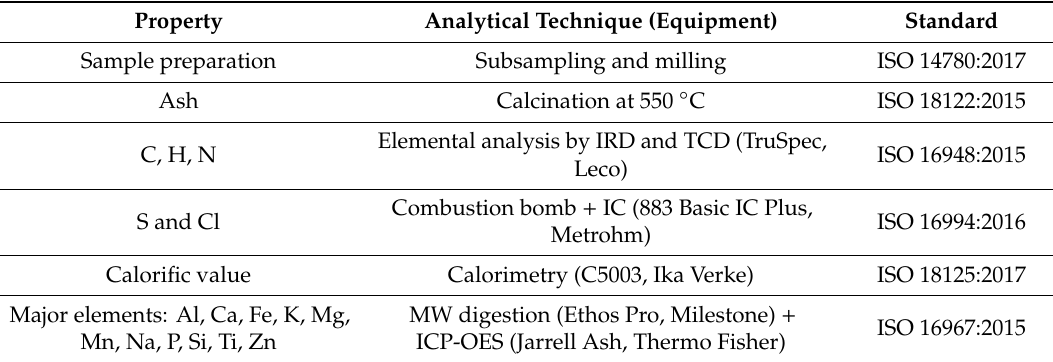
Table 1. Analytical techniques and standards followed during testing.